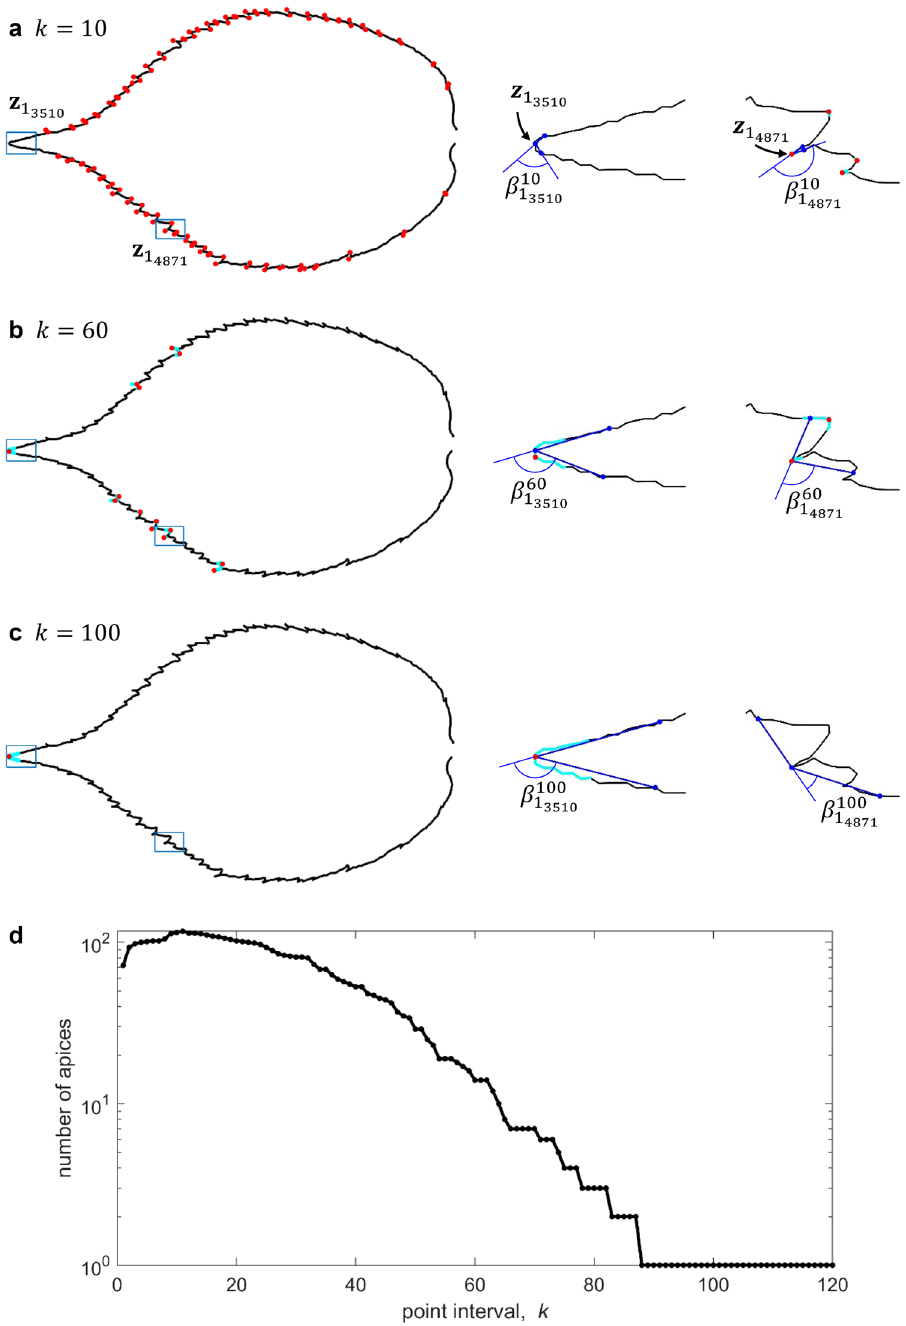
Figure 3. The process of locating a globally sharp corner (the tip) on the contour of a cherry leaf ( j = 1 from a total of 145 leaf profiles). The angle threshold T is set to 90°. ( a – c ) The apices detected via the relative angle at different point intervals. Cyan portions are where the relative angle is above T , and red points are the point where the largest relative angle occurs within that portion. The middle column and the right column shows the relative angle calculated at point z 1 3510 (the tip) and at point z 1 4871 (local burr) respectively. ( d ) The number of apices identified on the leaf contour while the point interval k